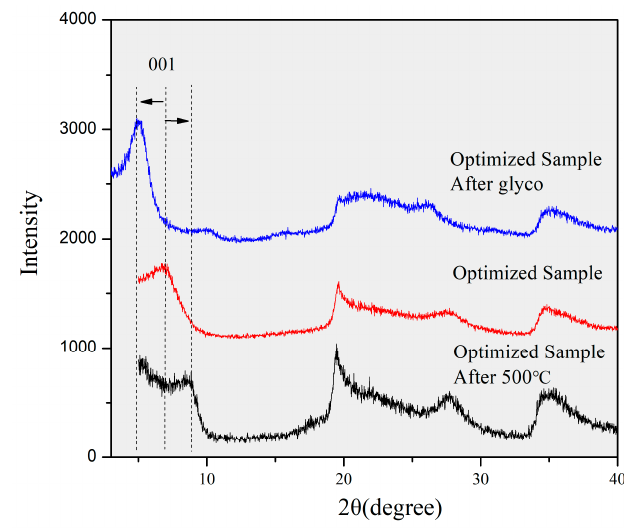
Figure 6. XRD analysis of optimized smectite synthesis products after heat and expansion treatment.